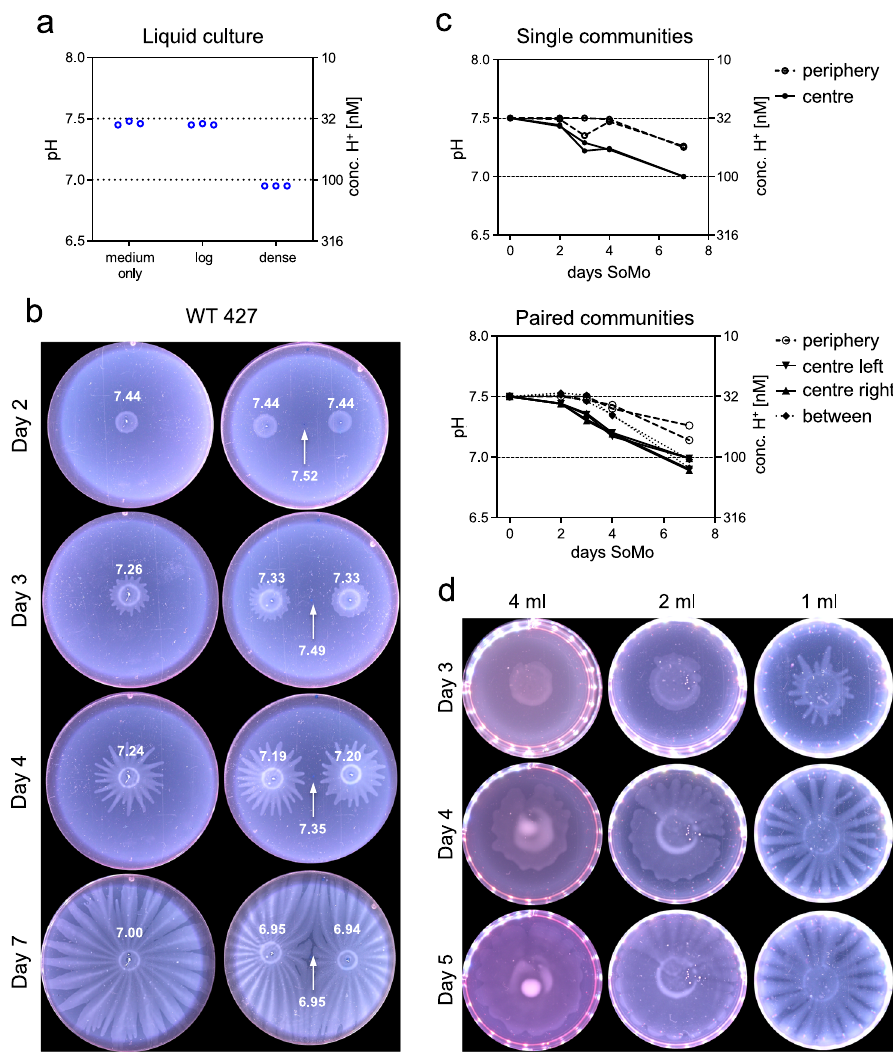
Fig. 2 Trypanosomes acidify their environment in liquid culture and on semi-solid agarose plates. Early procyclic forms (Lister 427 Bern) grown in SDM79 were analysed. a pH (left y -axis) of medium only, a log-phase culture (log, 3.9 × 10 6 cells ml − 1 ) and a dense culture (dense, 5.6 × 10 7 cells ml − 1 ). Three technical replicates are shown. The H + concentration is indicated on the right y -axis. Medium only was incubated for the same length of time as the cultures. b , c pH measurements on SoMo plates. b Trypanosomes (2 × 10 5 cells) were either spotted onto the centre of a plate as a single inoculum (left row) or in pairs (right row). White numbers indicate pH measurements on days 0, 2, 3, 4, and 7 in the centre of a community, at the periphery and in the space between two communities (indicated with a white arrow). c Graphs for pH measurement shown in ( b ). Each data point represents the pH measured from individual plates ( n = 2). Top: plates with single communities. pH at the plate periphery ( fi lled circle, dashed line) or in the centre of the community ( fi lled circle, solid line). Bottom: paired communities. pH at the plate periphery (open circle, dashed line), in the centres of the two communities ( fi lled triangle, solid line), or between them ( fi lled rhombus, dotted line). Y -axes are the same as in ( a ) . d The time-point of migration depends on the volume of the substrate. Equal numbers of early procyclic forms were inoculated onto wells that contained different volumes of medium with agarose. Plates were photographed on days 3, 4, and 5 post-inoculation. Source data are provided as a Source Data fi